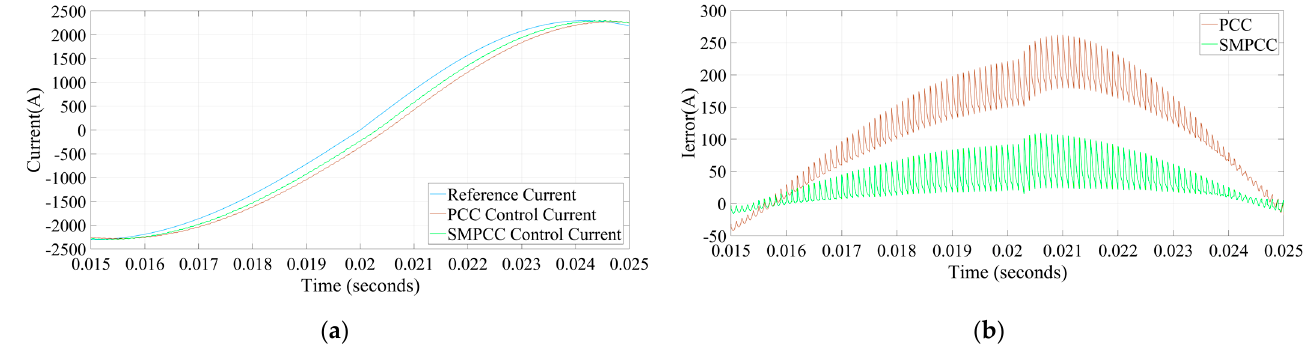
Figure 8. Simulation of a sudden increase in the output reference current frequency. ( a ) Control current; ( b ) Current error.